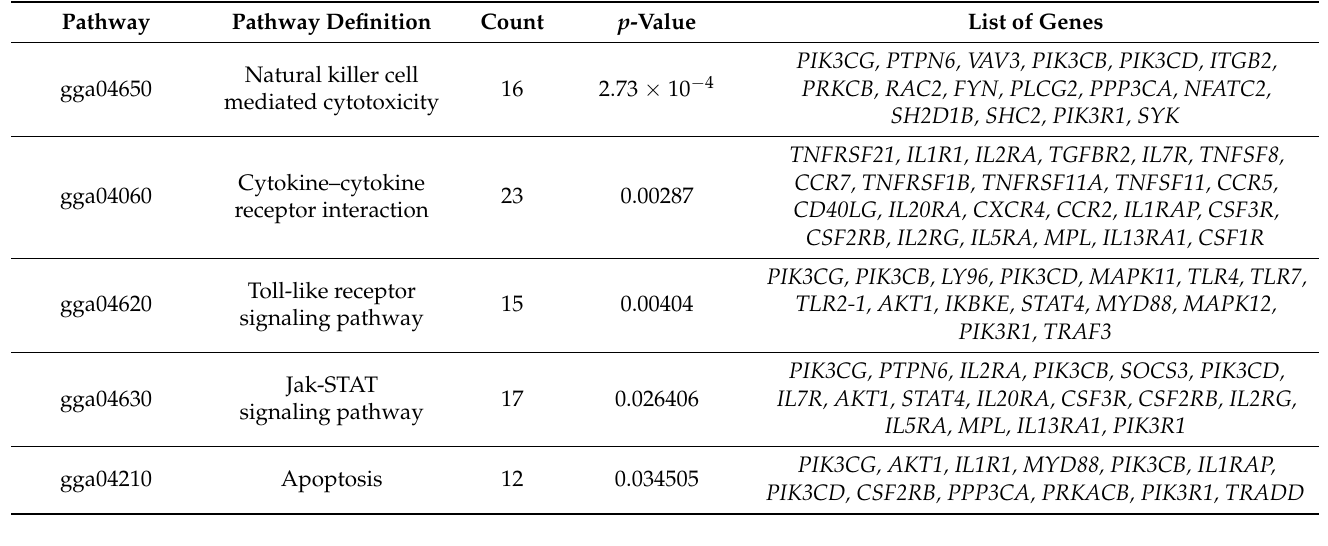
Table 4. Most significantly enriched KEGG pathways.